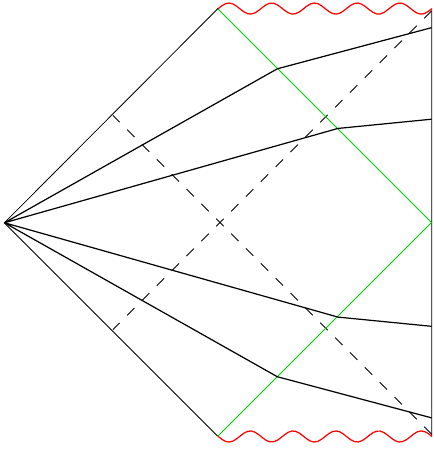
Figure 9 . Penrose diagram and examples of extremal Cauchy slices for the re(cid:13)ecting Vaidya